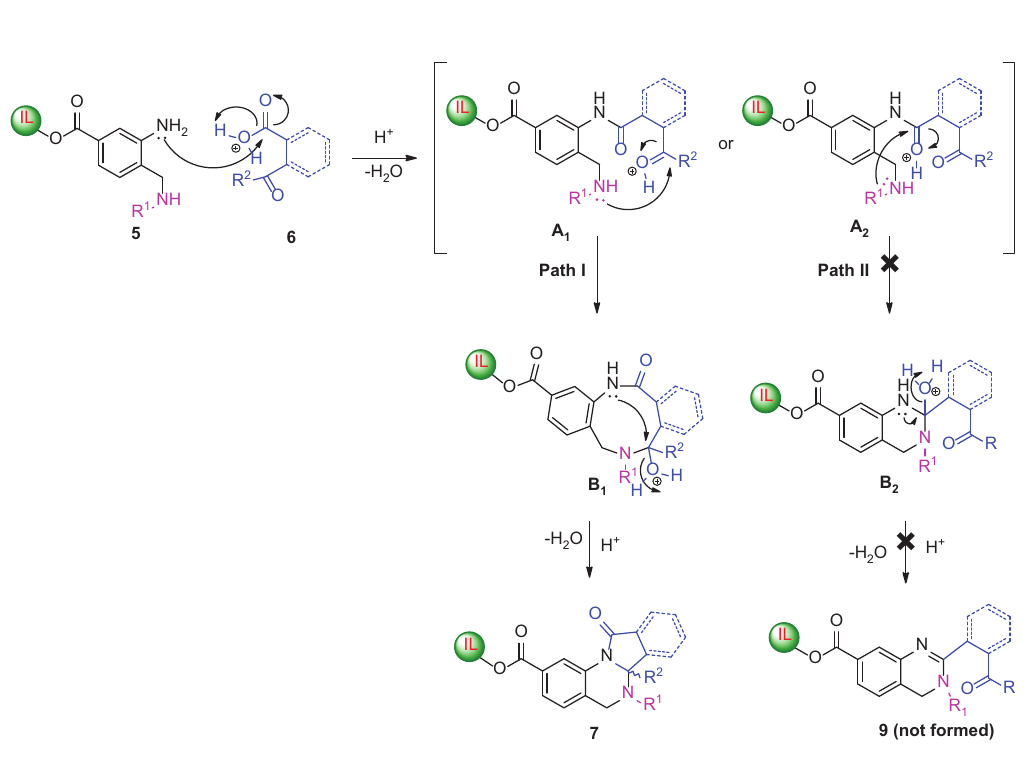
Scheme 4 Plausible mechanism for isoindoloquinazoline 7